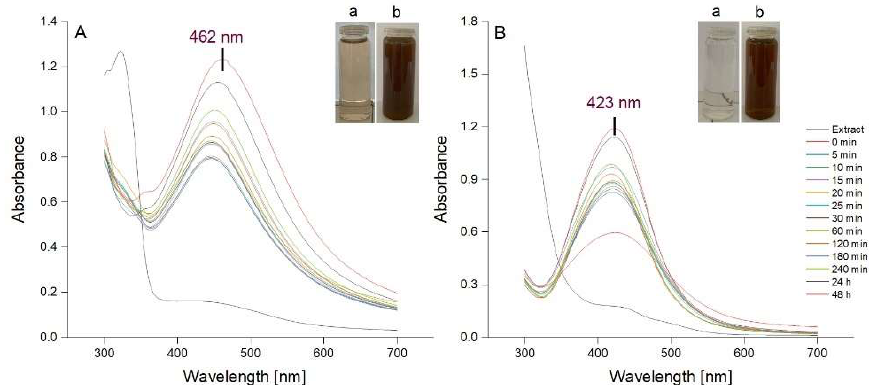
Figure 2. UV-Vis absorption spectra of AgNPs colloidal solutions synthesized using Picea abies ( A ) and Pinus nigra ( B ) aqueous bark extracts (a: extract + 1 mM AgNO 3 at time 0; b: extract + 1 mM AgNO 3 at 60